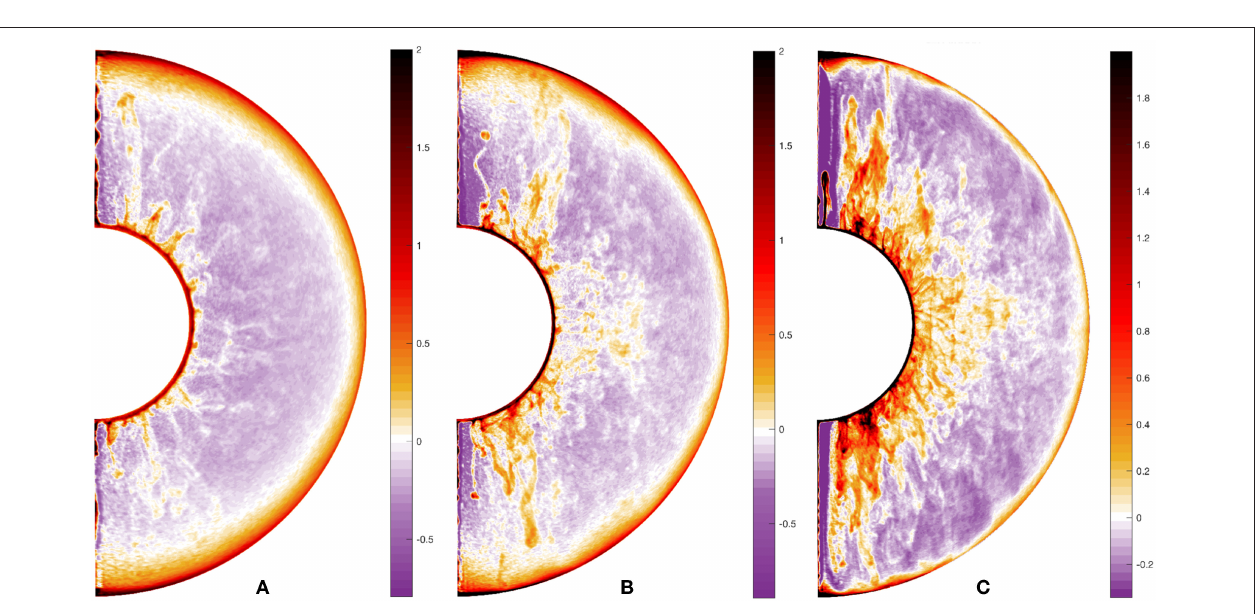
FIGURE 5 | Azimuthal average of the chemical field for cases 3 ( t Ro 1.9 10 − 3 and Ro 4.5 10 − 4 . The color scales have been deliberately modified and saturated in order to better visualize the structure of the compositional = × = × field in the convecting